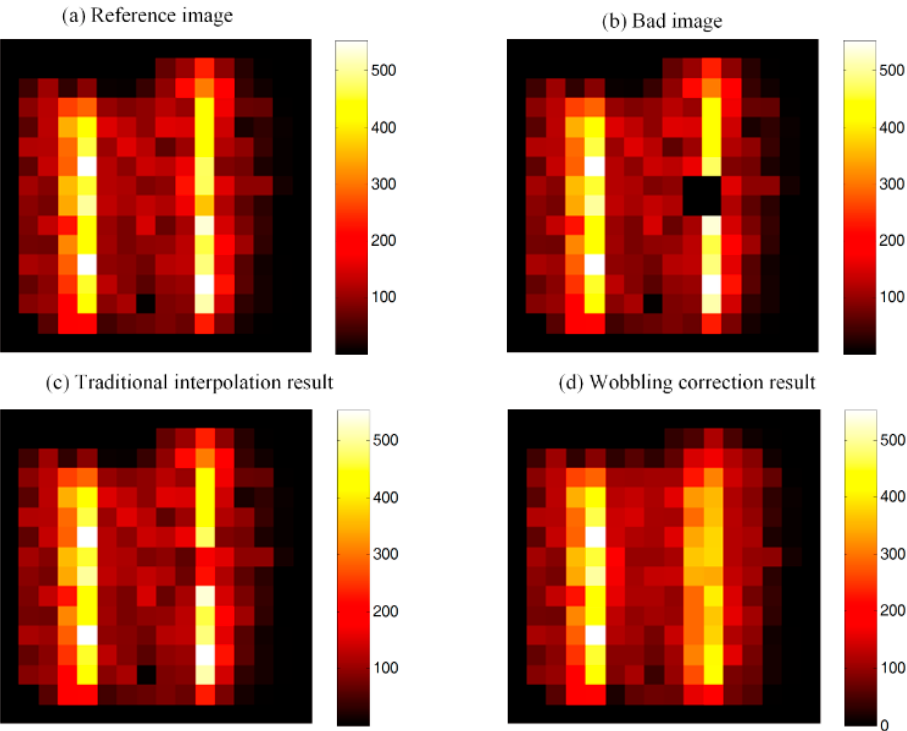
Figure 7. Results of the acquired line source phantom and correction results comparison. ( a ) Reference image: static imaging of line sources; ( b ) Bad image: image with 4 continuous bad pixels; ( c ) Conventional interpolation result: image using interpolation method; ( d ) Wobbling correction result: image using wobbling correction method.